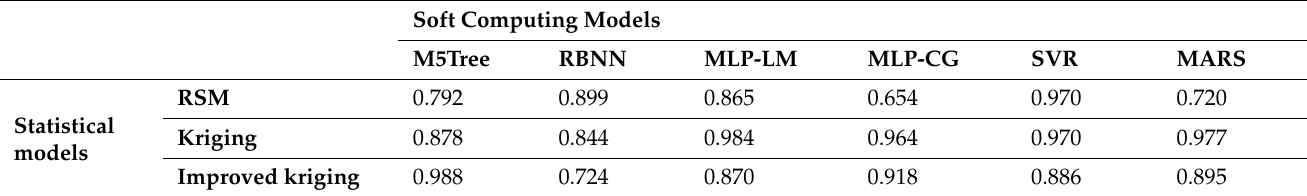
Table 7. p -Values of the Mann–Whitney Test for statistical methods versus soft computing models in Adana Station.